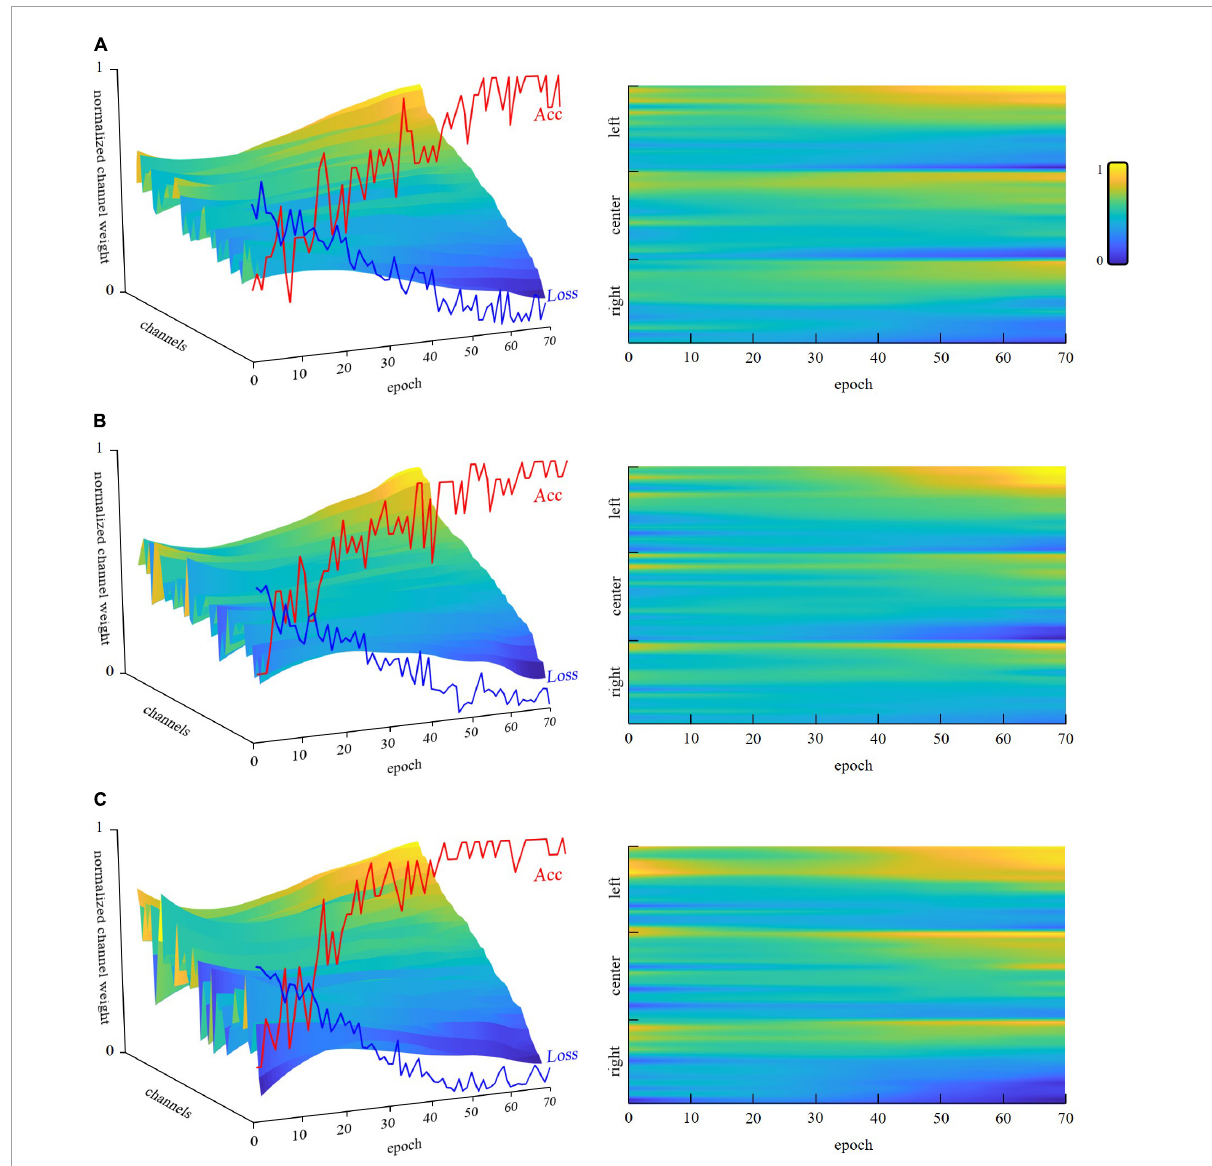
FIGURE8 The channel weights fitting with the training process of the attention-based convolutional neural network (CNN). The left panel shows all channel weights sorted in the order of the final training results. All channels are sorted by the last loss value. The right panel presents a top-down view of the left panel. However, the channels are re-ranked into the left, center, and right regions. We list the three groups in Supplementary Table 1 . The right panel has two axes: re-ranked channels and epochs. The normalized channel weight is represented by color bars. (A) 1-back, (B) 2-back, (C)